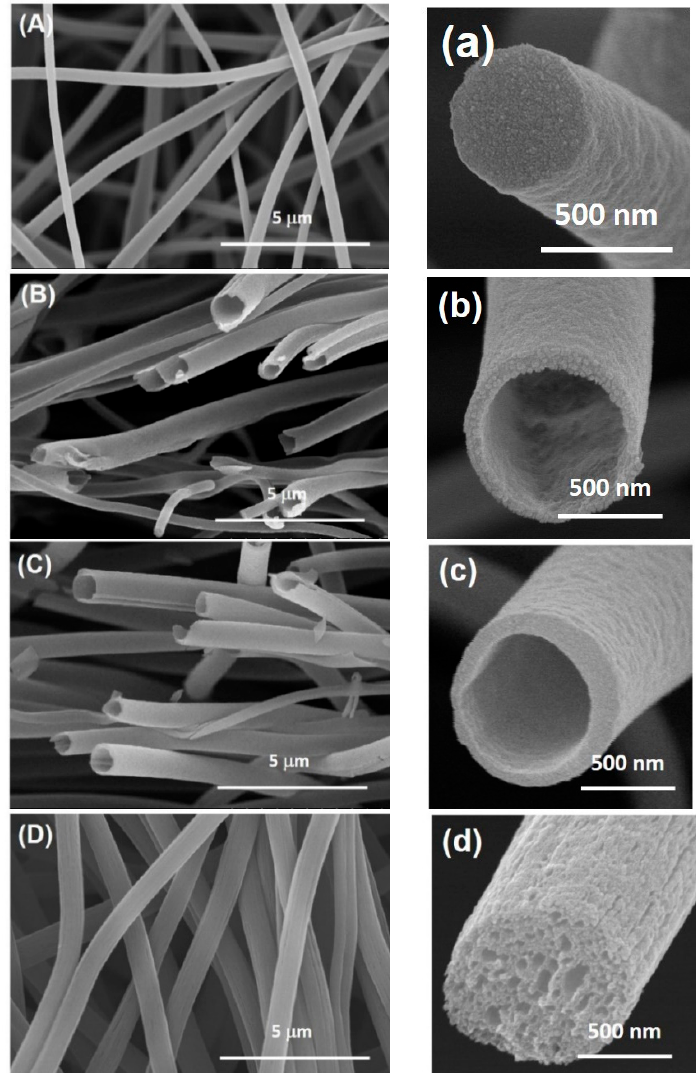
Figure 2. FESEM images of the ACNFs: ( A , a ) PANf; ( B , b ) PANh15; ( C , c ) PANh12; ( D , d ) PANp.